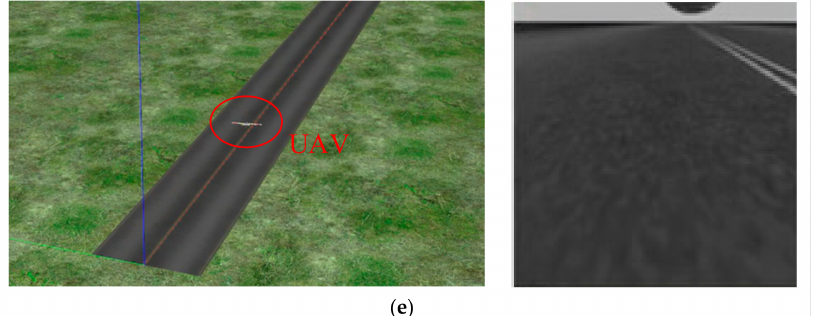
Figure 13. The landing process under case 2 ( a – e ). ( a ) t = 0.0 s; ( b ) t = 0.13 s; ( c ) t = 1.09 s; ( d ) t = 2.11 s; ( e ) t = 3.06 s.